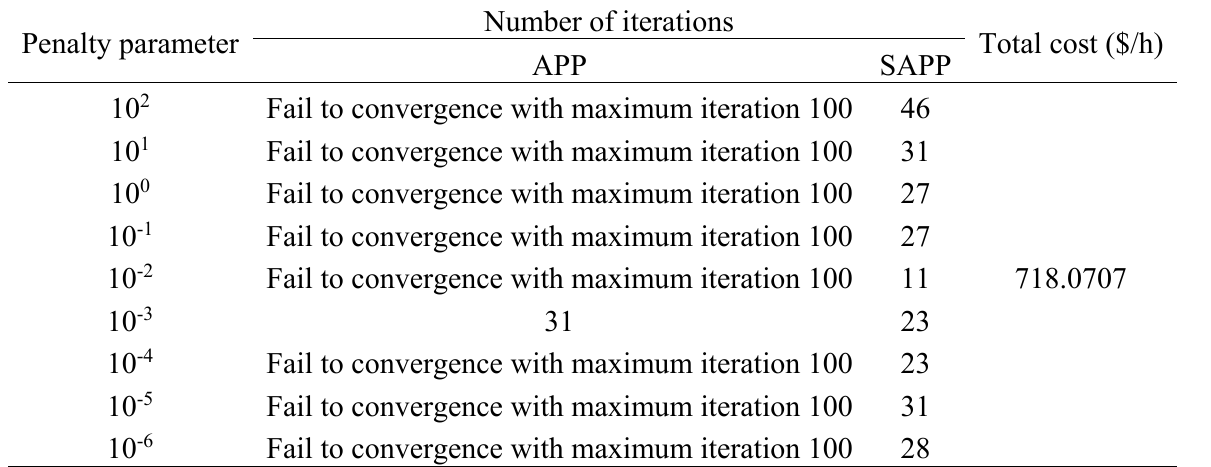
Table 2. Comparison of results for test system